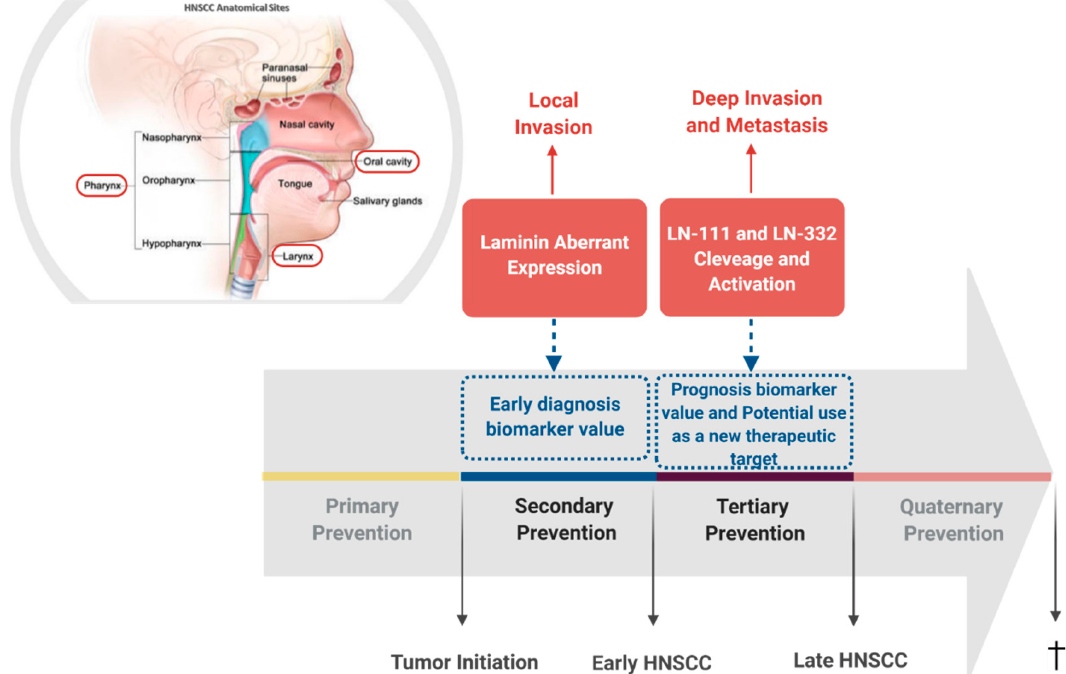
Figure 2. Laminin involvement in head and neck squamous cell carcinomas (HNSCC) progression. Schematic representation of HNSCC most frequent affected anatomical sites and summary of the already identified involvement of laminin in HNSCC, pointing out its intervention potential in tumor’s natural history. Head and neck anatomical sites from where the squamous cell carcinomas discussed in this review arise are highlighted by a red frame. Secondary prevention is high- lighted since the aberrant expression pattern of laminin in HNSCC unveils a potential value of its use as early diagnosis biomarker. Likewise, tertiary prevention is also highlighted since cleavage and activation of laminin trigger intracellular signaling pathways that lead to the acquisition of a malignant phenotype and may represent a potential new therapeutic target. Additionally, cleavage and activation of laminin are associated with patient outcome, indicating a potential value of its use as prognosis biomarker.